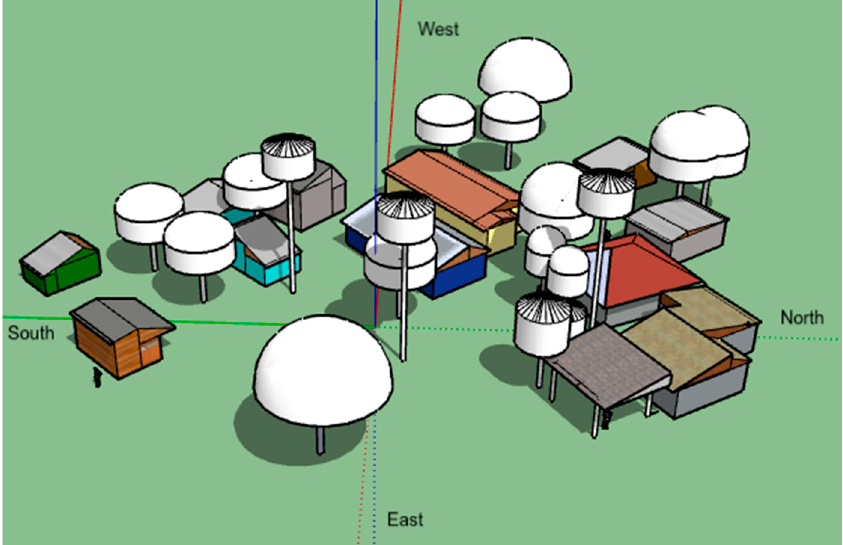
Energies 2021 , 14 , x FOR PEER REVIEW Figure 5. The 3D model of the actual 11 houses in the case study site. Figure 5. The 3D model of the actual 11 houses in the case study site.